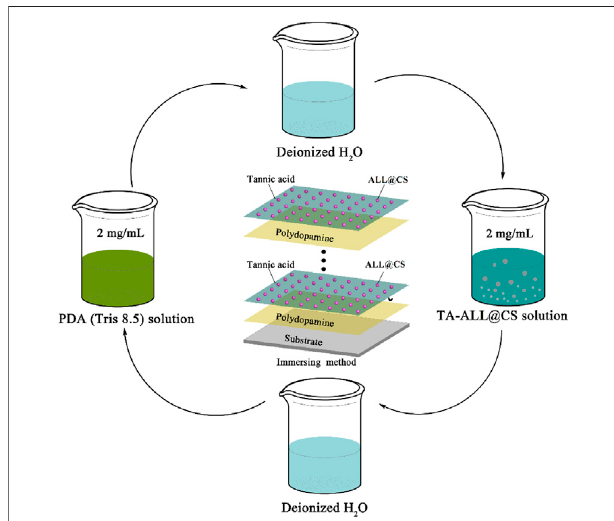
FIGURE 5 | Schematic diagram of the preparation procedure of PDA/ TA-ALL@CS coatings.